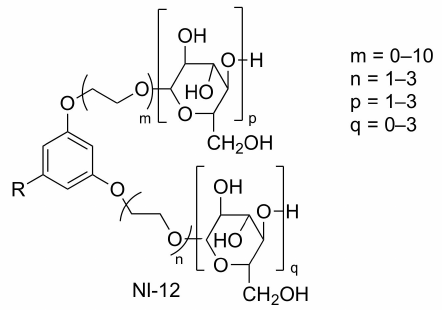
Figure 8. Cardol-based surfactant with poly(ethylene oxide) and glucose as polar groups. Toxic and petroleum-based ethylene oxide was used in this reaction. The biobased part of such molecules can be varied between 46 and 97% according to the length of PEO chains and/or the number of glucose units. The surface tension properties of such products were not described in the